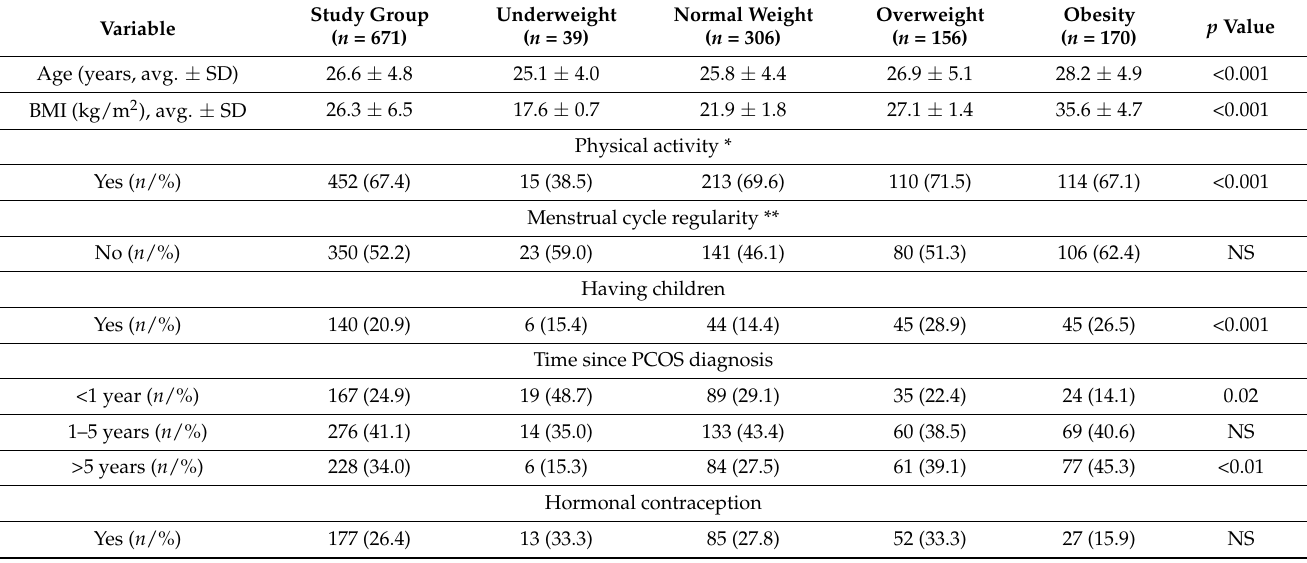
Table 1. Characteristics of